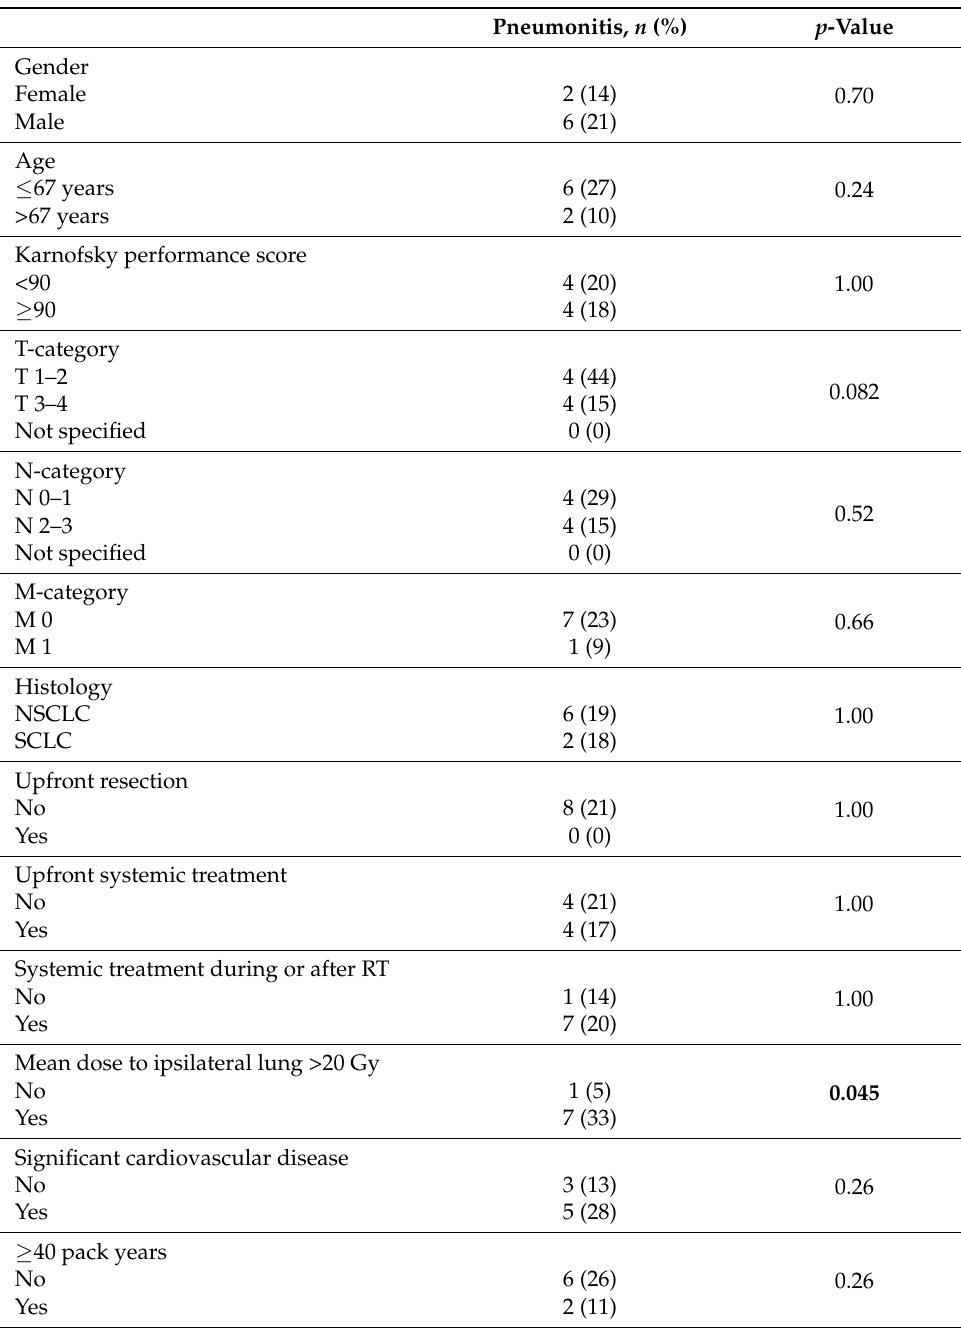
Table 3. Characteristics of the 42 patients eligible for the primary endpoint, evaluation of presence or absence of radiation pneumonitis, and corresponding pneumonitis rates. p -values were calculated with Fisher’s exact test. Pneumonitis, n (%) p